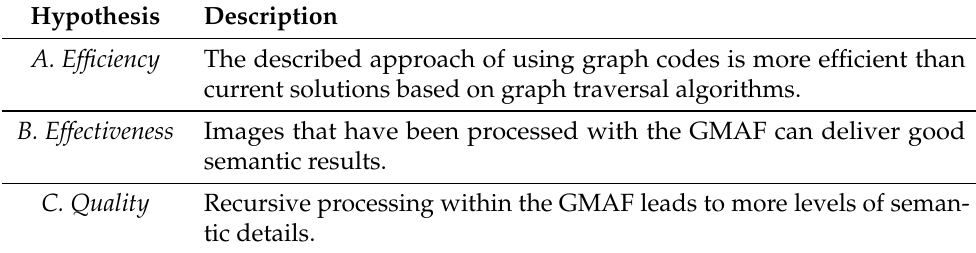
Table 2. Hypotheses to be proved by the experiments.